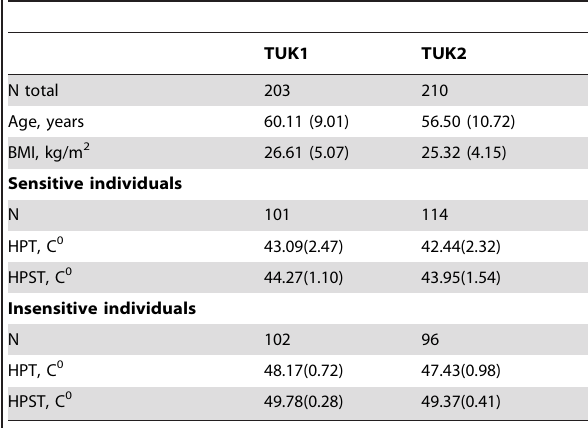
Table 1. Characteristics of the individuals in the TUK1 and TUK2